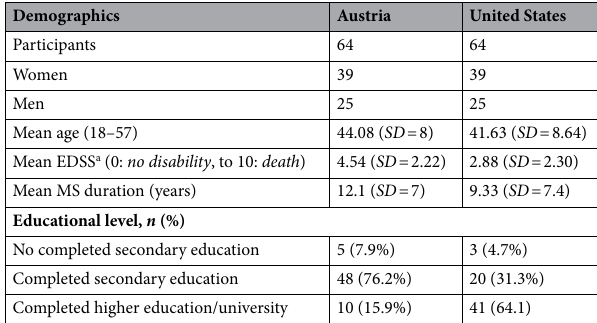
Table 1. Sample demographics. a Expanded Disability Status Scale